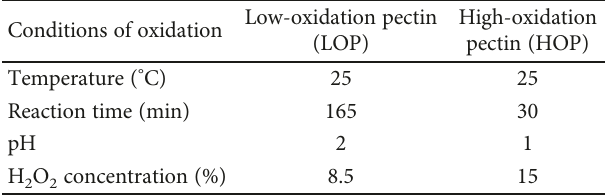
Table 1: Summary of the conditions for pectin oxidation.